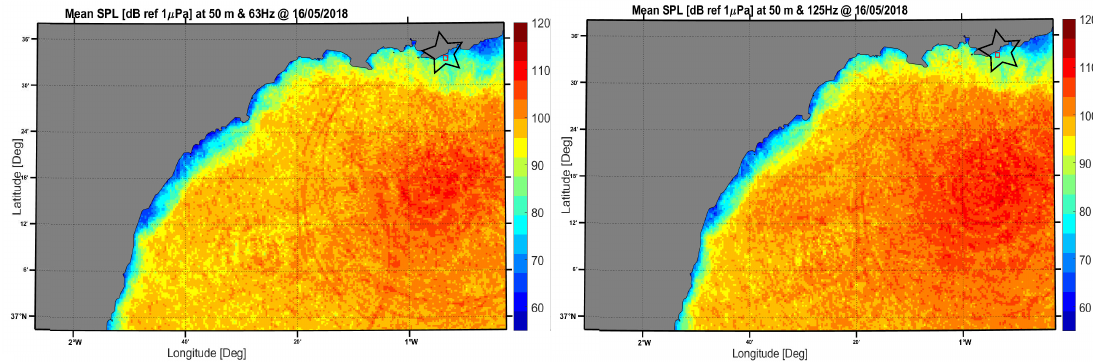
Figure 7. Sound map on 16/05/2018 at 63 Hz (left) and 125 Hz (right) calculated over the region studied.